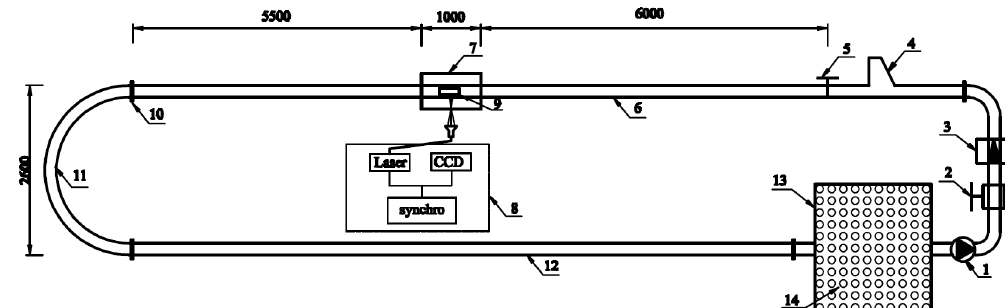
Figure 3. Layout sketch of experiment facilities. 1, centrifugal pump; 2, gate valve; 3,electromagnetic flowmeter; 4, placement device; 5, braking device; 6, straight pipe segment; 7, square water jacket; 8, particle image velocimeter (PIV); 9, capsule; 10, flange; 11, bend pipe; 12, straight pipe segment; 13, water tank; 14, steady flow grid.